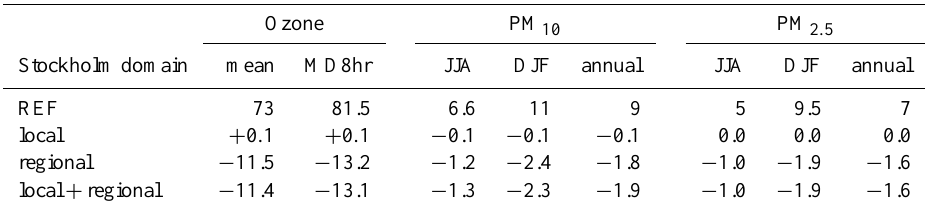
Table 5. Contribution of the emission reduction policies implemented at the local and regional scale to the future concentration changes of ozone, PM 10 and PM 2 . 5 in the Stockholm